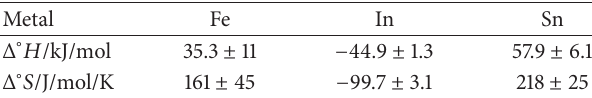
Table 5: Δ ∘ 𝐻 and Δ ∘ 𝑆 for extraction from 0.1M HCl. Values are obtained by linear fitting of